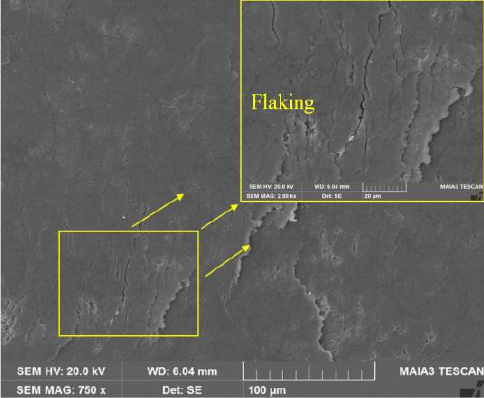
Figure 5. SEM micrograph of the worn surface of the D-gun coating technique at 250 °C under 2 N load.